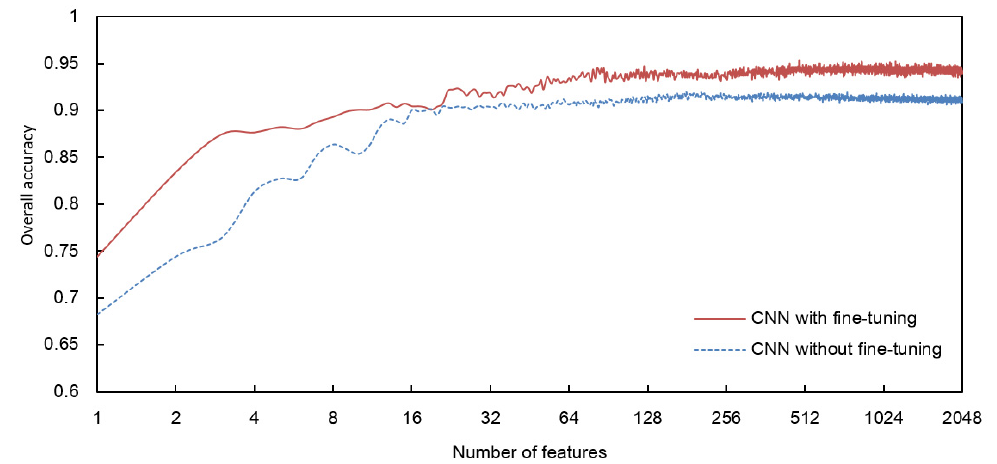
Figure 5. Effect of the number of selected features on the classification accuracies by convolutional neural network (CNN) models using and without using fine-tuning